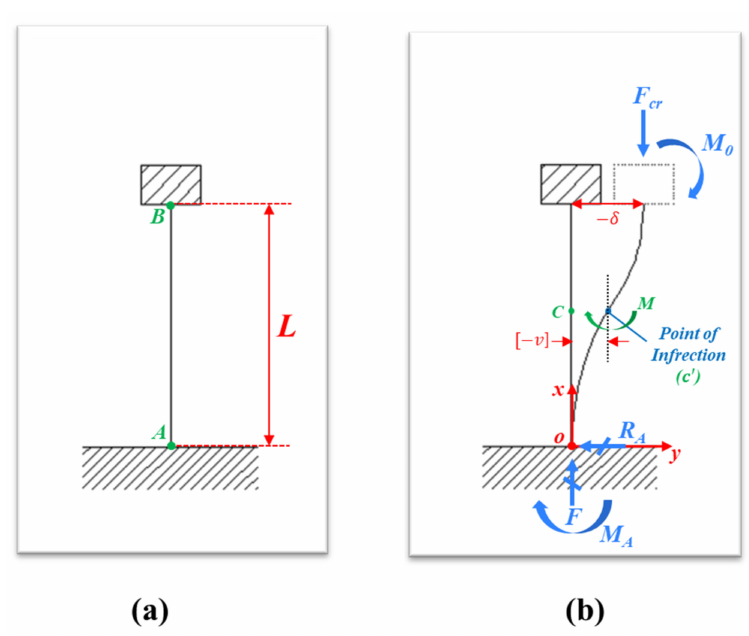
Figure 6. A simple analytical schematic of a pillar in ( a ) stable and ( b ) buckled